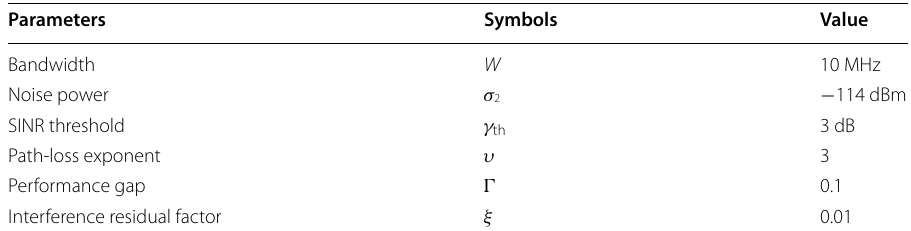
Table 1 Simulation parameter settings Parameters Symbols Value